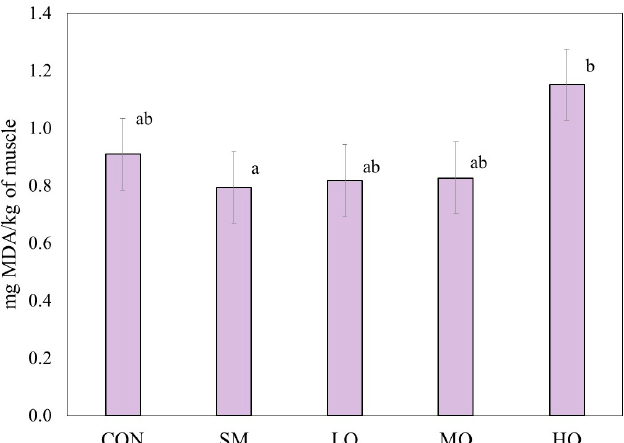
Figure 1. Means (± S.E.) of thiobarbituric acid reactive substances (TBARS) values (mg malonaldehyde (MDA)/kg of muscle) in m. Longissimus lumborum of male lambs unsupplemented (CON) or supplemented with monensin (SM), or three different levels of oregano essential oils: low (LO = 0.2 g/kg of dry matter (DM)); medium (MO = 0.3 g/kg of DM) or high (HO = 0.4 g/kg of DM). TBARS analysis was performed after 7 d of simulated retail display in modified atmosphere packaging (O 2: CO 2 , 75:25%). a, b Different superscripts mean significant difference ( p ˂ 0.05) among treatments within the variables.